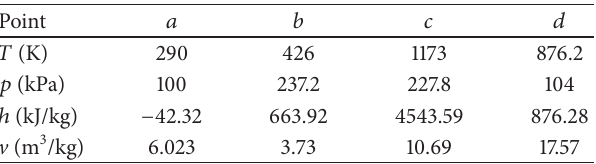
Figure 6: The stand alone RC thermal efficiency and specific power as function reheating pressure operating with carbon dioxide, computed with data from Table 4. Table 5: The CBC with helium as WF operating with a TIT of 1173K and pressure ratio of 2.37.